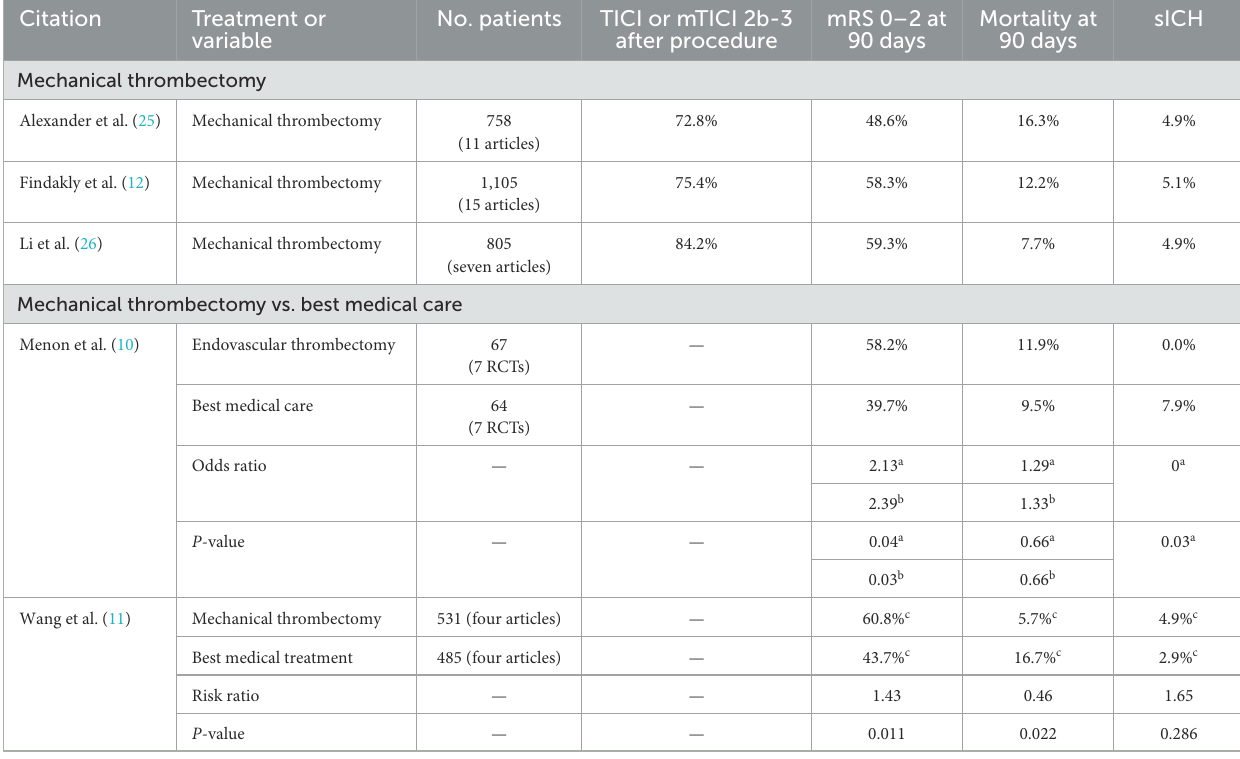
TABLE 4 Recent meta-analyses on the results of mechanical thrombectomy for acute ischemic stroke due to M2 middle cerebral artery